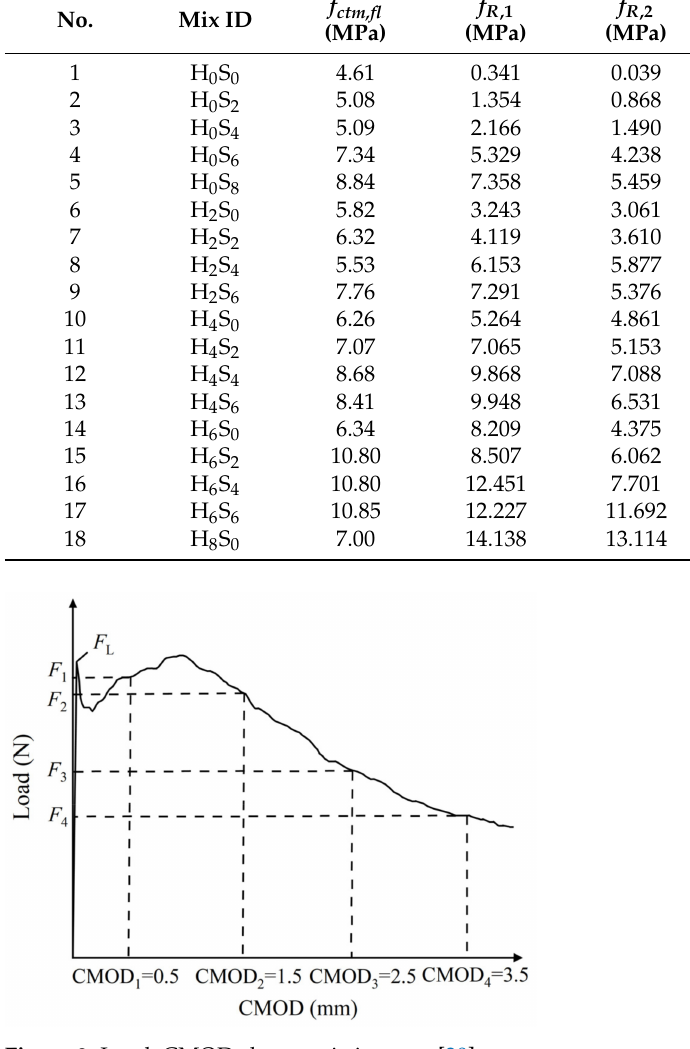
Figure 9. Load–CMOD characteristic curve